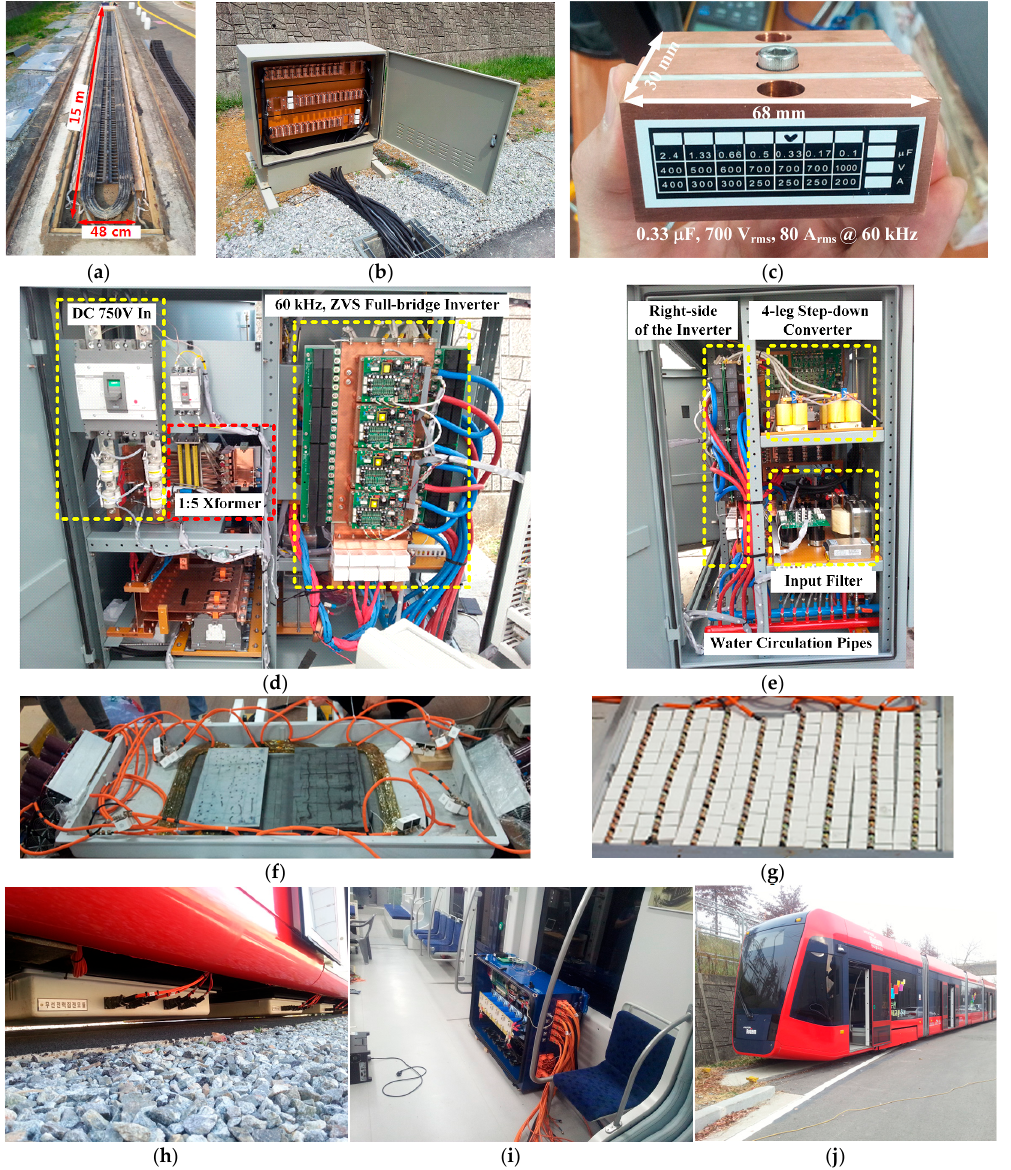
Figure 10. Photographs of the developed test-bed: ( a ) transmitter; ( b ) transmitter tuning capacitor bank; ( c ) transmitter tuning capacitor; ( d ) the PAM inverter; ( e ) interleaved DC-DC converter; ( f ) pick-up winding; ( g ) pick-up tuning capacitors; ( h ) installed three pick-ups; ( i ) pick-up output voltage regulator; and ( j ) target tram.